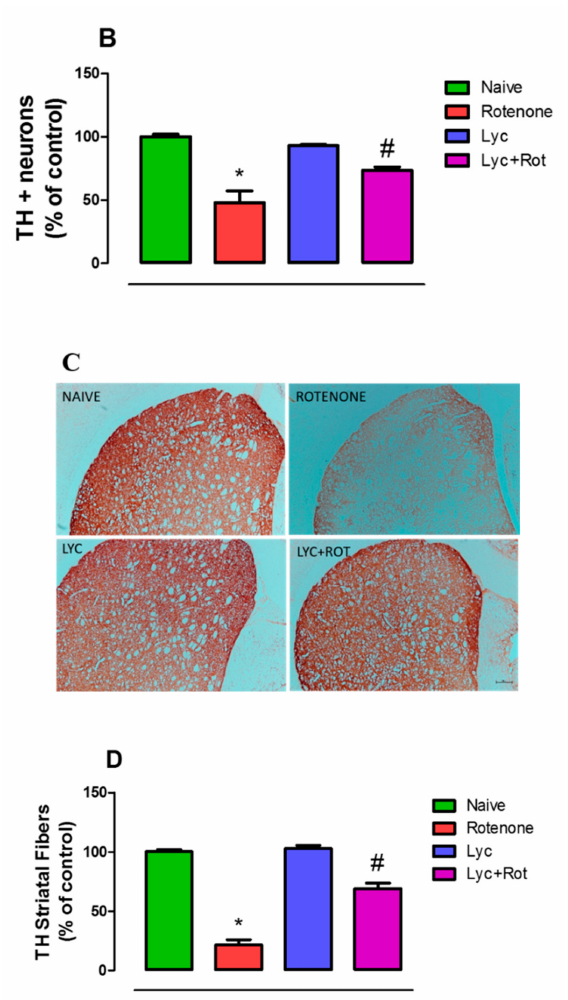
Figure 8. Lyc prevented dopaminergic neurodegeneration. Immunohistochemistry of 20 µ m coronal sections with anti-tyrosine hydrolase antibody of substantia nigra ( A ) and striatum ( C ) of experimental animals. Rotenone administration caused the significant loss of both TH + ve neurons and neuronal fibers in the substantia nigra and striatum, respectively. Whereas, administration of Lyc prevented this loss significantly. Quantification of tyrosine hydrolase positive neurons ( B ) and densitometric analysis of tyrosine hydrolase positive neuronal fibers ( D ) were performed using Image J Values are expressed as mean ± SEM. * p < 0.05 compared to control, # p < 0.05, compared to the rotenone-treated